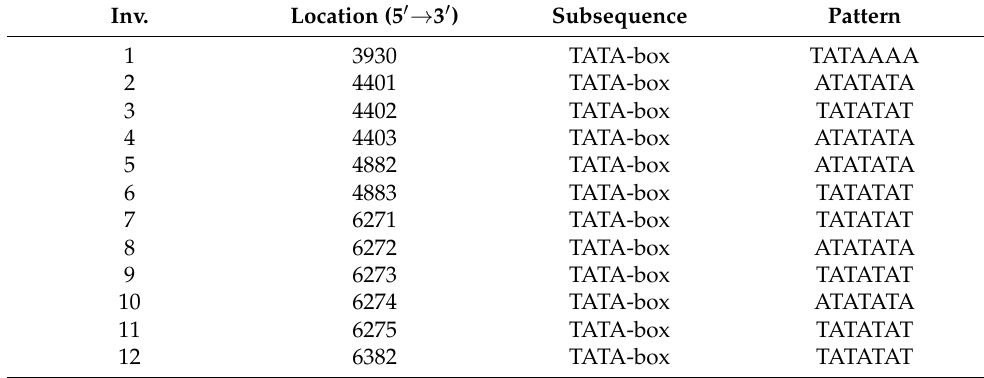
Table 2. TATA-Boxes on the MYCN